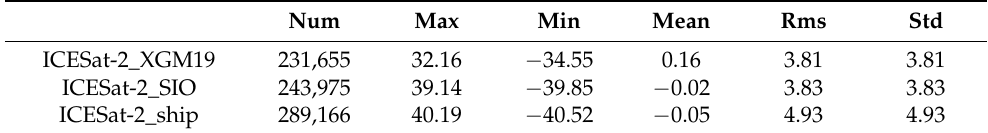
Table 19. Statistics of differences between the cross-beam DOV-derived gravity anomalies and the XGM2019e_2159-GRA model, SIO V31.1-GRA model, and ship-borne gravity anomaly data (Unit: mGal). Num Max Min Mean